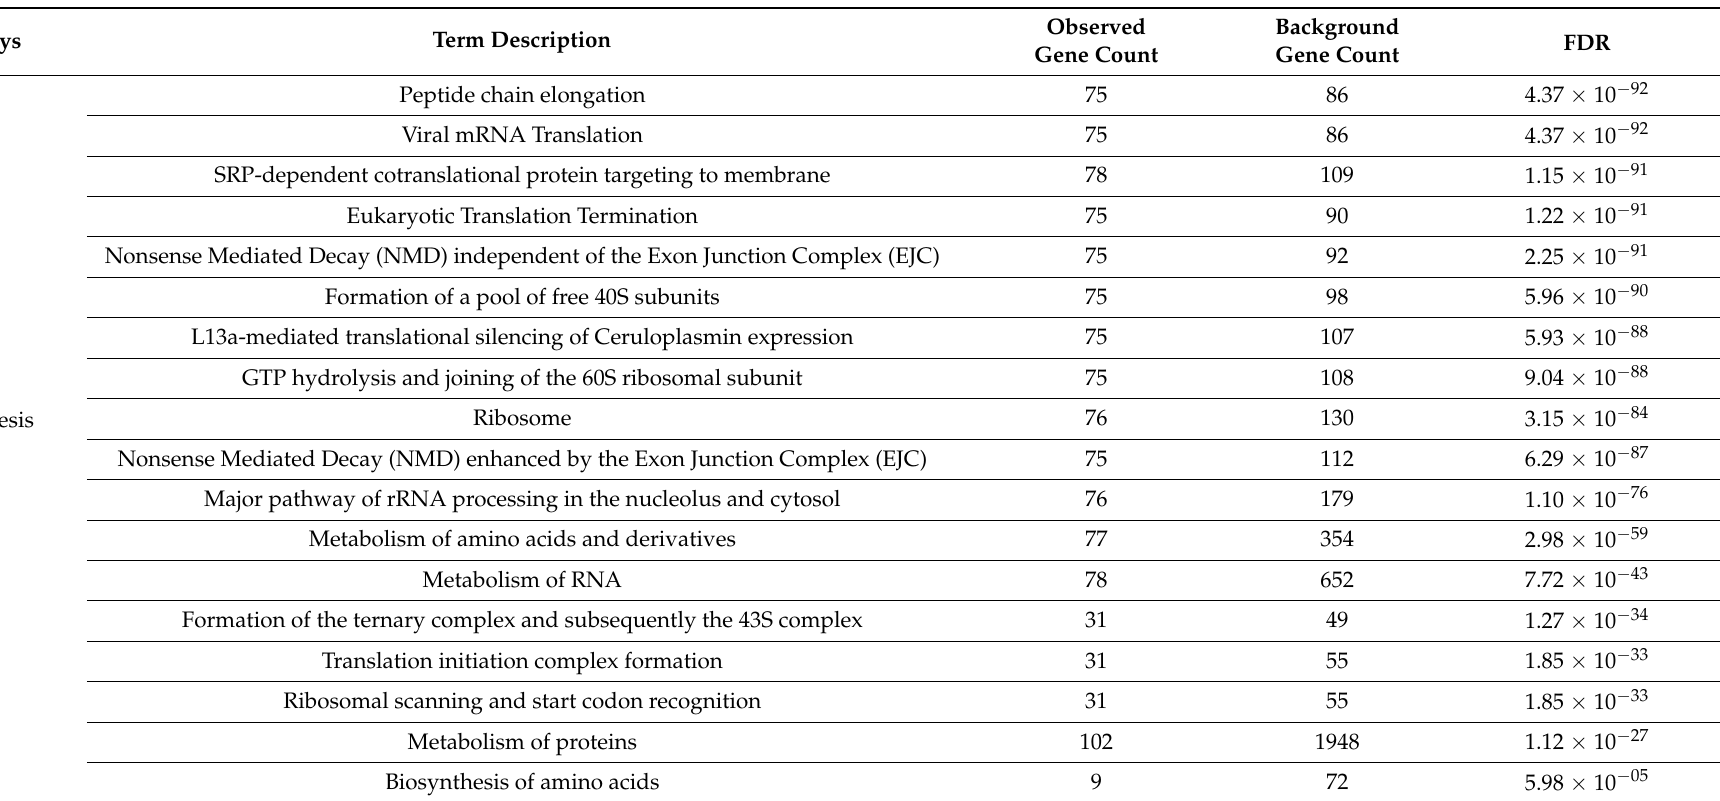
Table 2. Enriched cellular pathways influenced by MnCl 2 in RA-differentiated SH-SY5Y cells, after gene ontology analysis using the String database. Cell